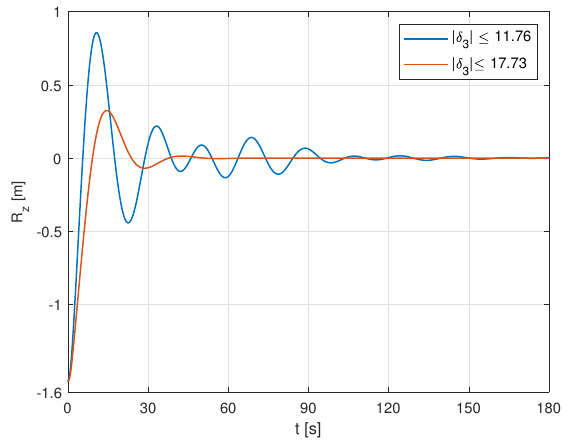
Figure 19. Position of the center of